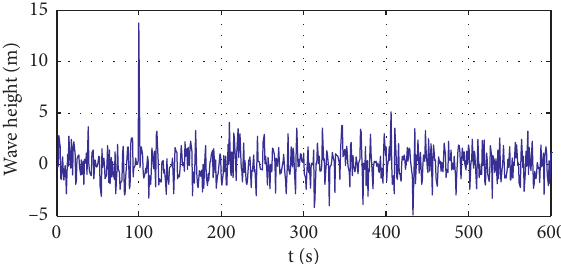
Figure 5: Time simulation results of freak waves based on random phase modulation when t